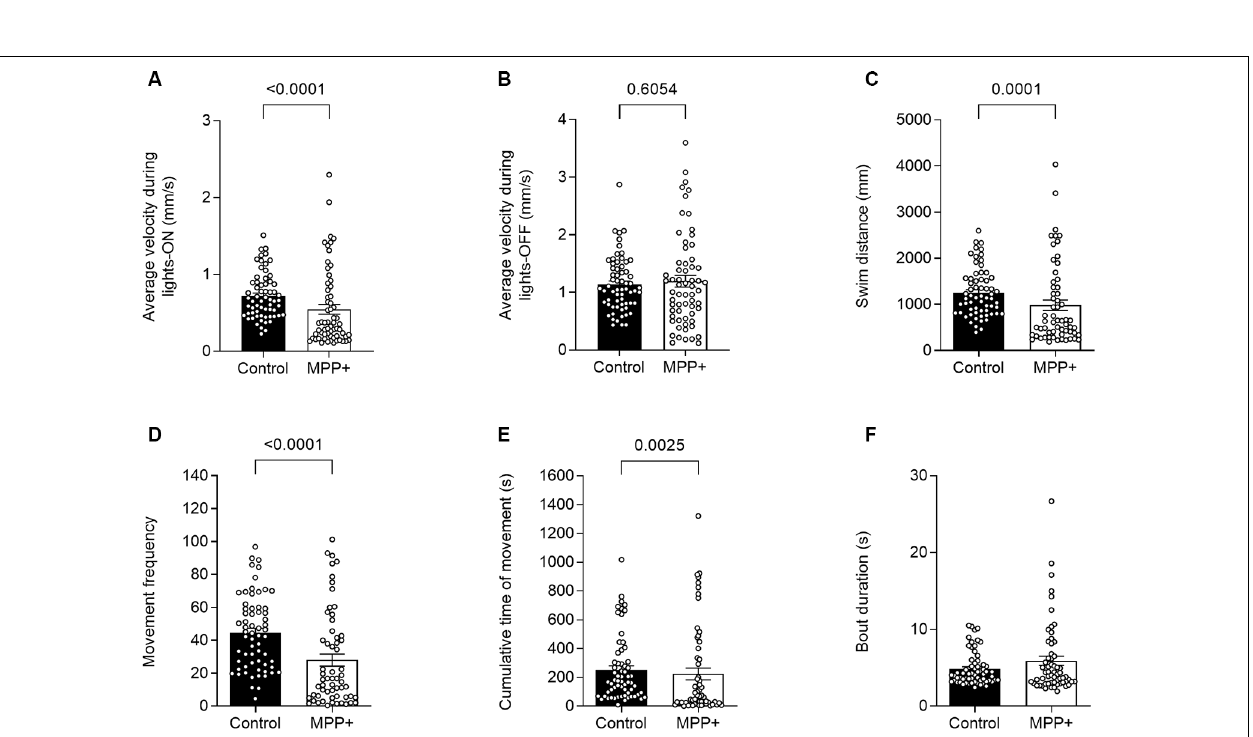
FIGURE 2 | MPP+ effects on motor activity of zebrafish larvae. Motor activity was evaluated at 6 days post fertilization (dpf) in absence (Control) or presence of 500 µ M MPP+ for (A) average velocity (mm/s) during lights-on and; (B) lights-off; (C) distance swam (mm); (D) frequency of movement; (E) cumulative time of movement (s) and (F) movement bout duration (s) were examined during five consecutive light-on phases. Data are presented as means ± SEM from two independent experiments pooled, control group n = 64, MPP+ group n = 61. Normality was tested using the D’Agostino and Pearson omnibus normality test followed by the nonparametric two-tailed Mann–Whitney U